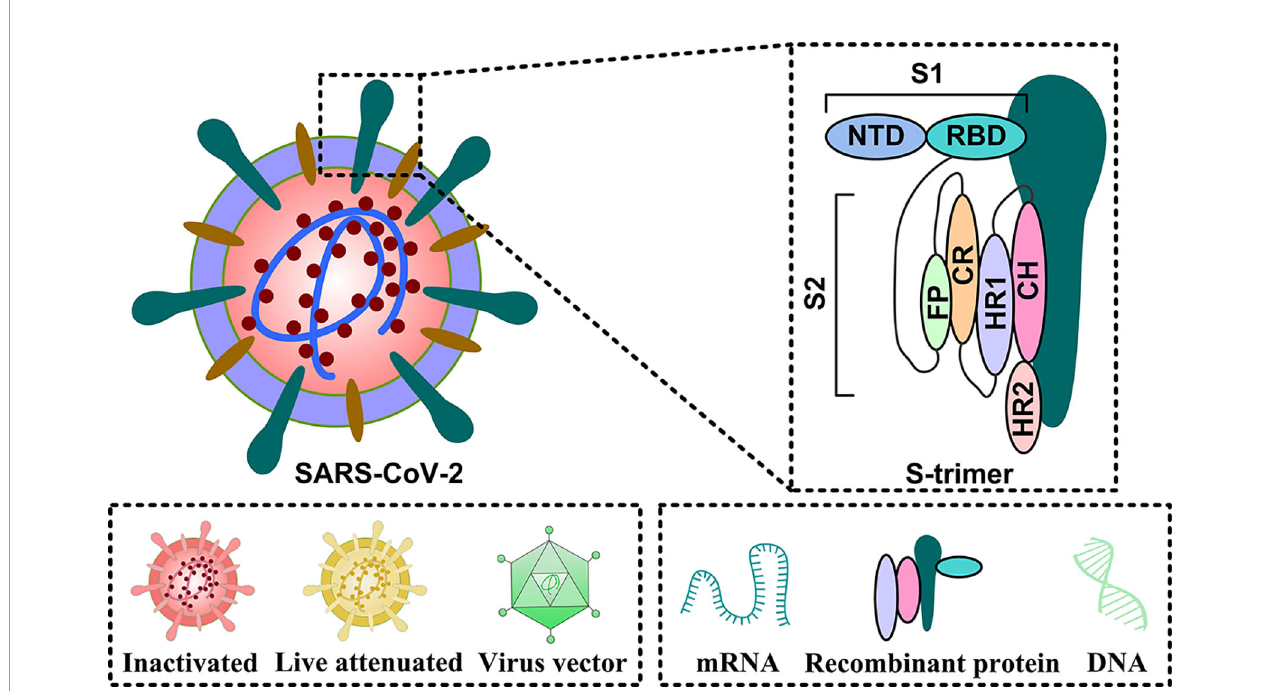
FIGURE 2 | The primary targets of the COVID-19 vaccine candidates. The entire virus can be used as antigen in the following forms: inactivated, live attenuated, and virus vector vaccines. In some cases, functional proteins can also be employed as antigens. These include: mRNA, DNA, and recombinant